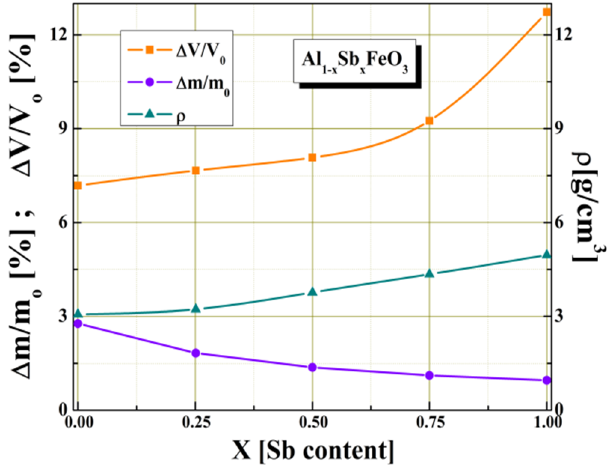
Figure 1. The Sb 3+ cations content variation of some structural parameters.